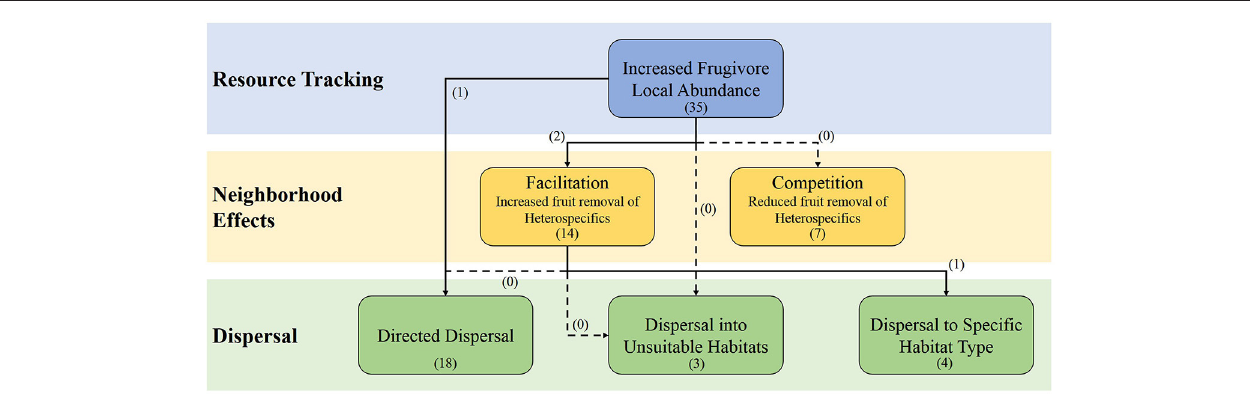
FIGURE 1 | The influence of resource tracking on the fruit removal and potential seed dispersal through different types of neighborhood effects. The dashed arrows represent the links that where our literature search provided no studies investigating them. The numbers in parentheses represent the number of studies that investigate the process or link as determined by Web of Science topic searches (see Appendix 1 in Supplementary Materials for search terms).